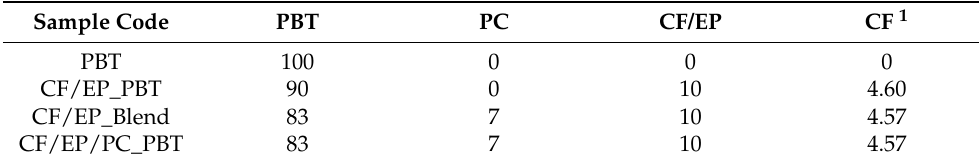
Table 1. Composition (wt%) and codes of the investigated